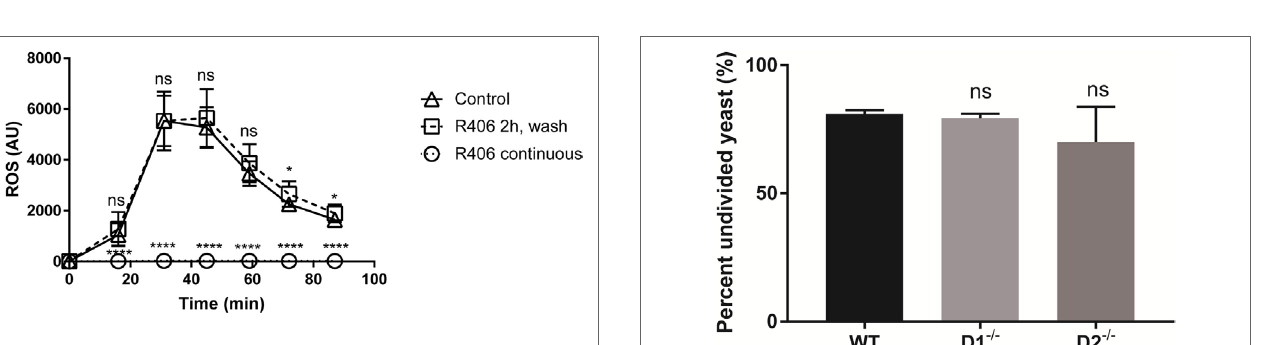
FigUre 6 | R406 does not result in permanent macrophage response defects to fungal stimuli as measured by reactive oxygen species (ROS) production. Plated macrophages were treated with R406 for 2 h, and then washed to remove the inhibitor. ROS production measured by lucigenin after addition of heat-killed Candida . Arbitrary light unites (AU) represents total luminescence corresponding with ROS production. * p ≤ 0.05, **** p ≤ 0.0001. Data represent a minimum of three independent experiments.